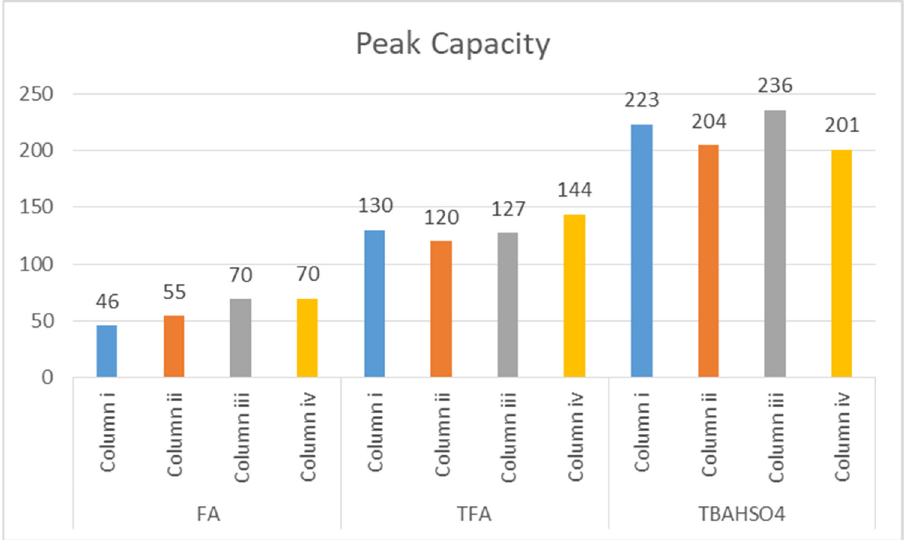
Figure 6. Peak capacity ( nc ) values.